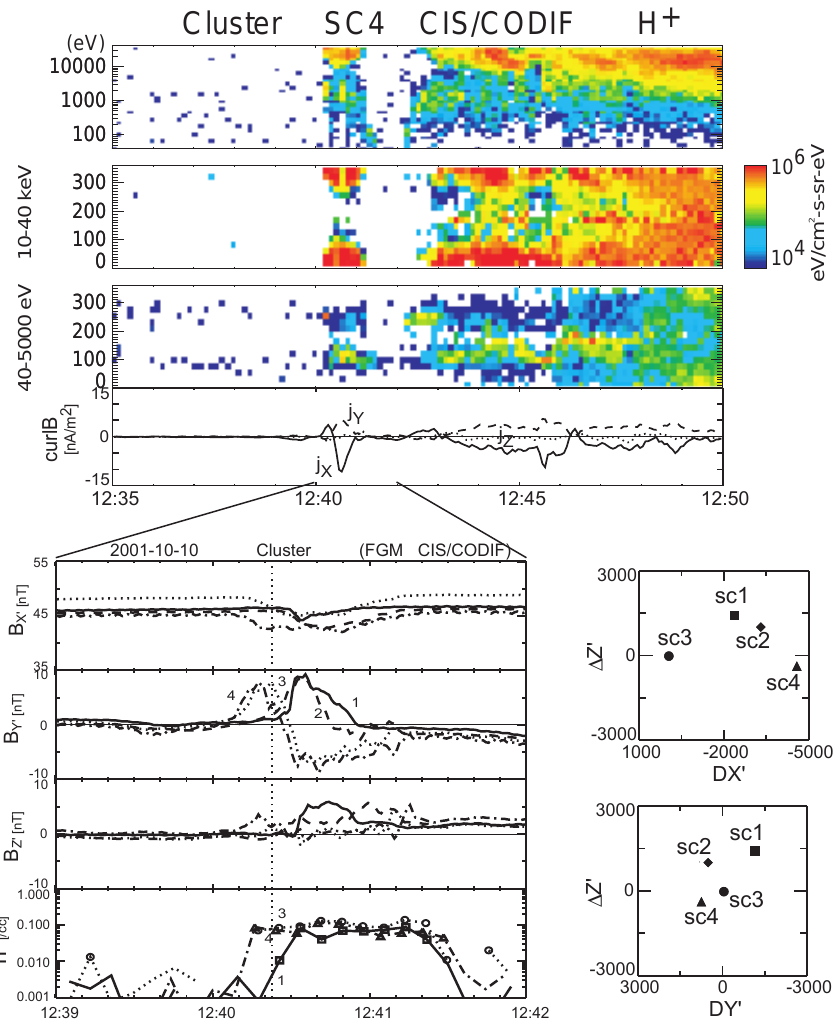
Fig. 13. Observation of a transient field-aligned current at the plasma sheet boundary layer. Proton energy spectra, pitch angle distribution of high energy (10–40keV) and low energy (40eV–5keV) protons for C4, and current density obtained from four spacecraft data are shown in the top panel. The relative location of the four spacecraft in the plasma sheet boundary coordinate system is given in the two panels at the lower right. Magnetic field from C1-C4 and proton density from C1 and C3 during the first plasma sheet encounter are shown in the lower left panels for the time interval when Cluster observed strong field-aligned currents. (Adopted from Nakamura et al.,